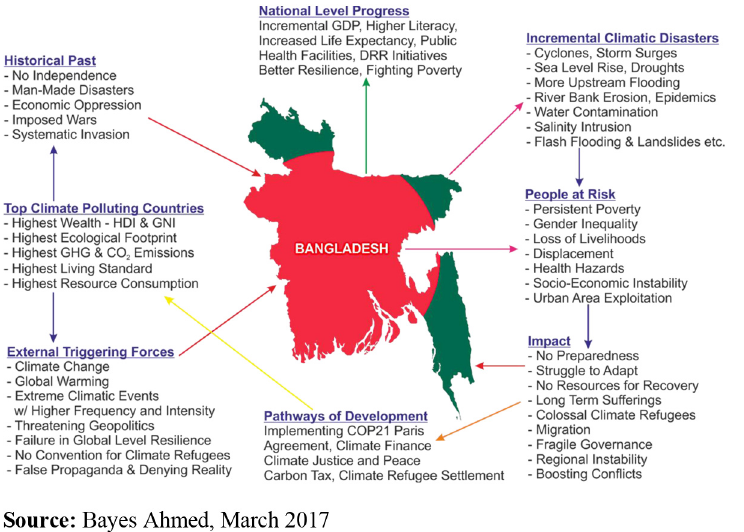
Figure 2. The pathways to achieve sustainable development goals by addressing the climate change impacts in